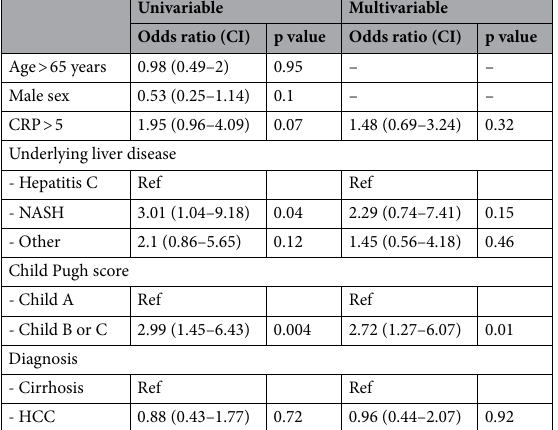
Table 4. Univariable and multivariable logistic regression on factors associated with H3Cit-DNA above or below 200